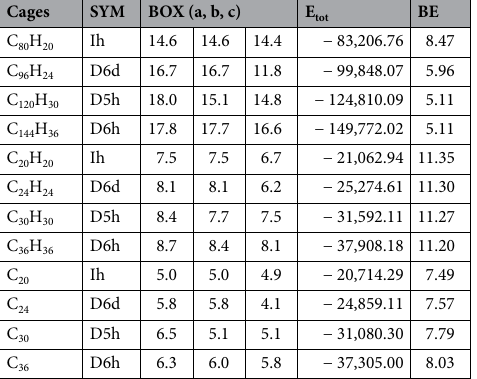
Table 1. Geometrical properties of the introduced fullerynes and the corresponding fulleranes and fullerenes (in units Å and eV).